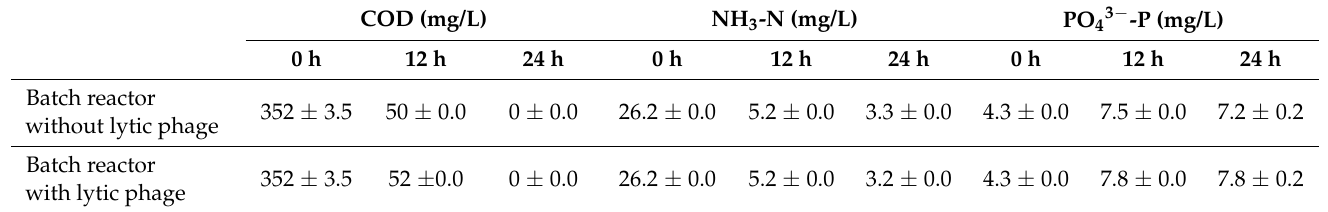
Table 2. Water quality monitoring in batch reactors with and without Aerophage treatment. COD